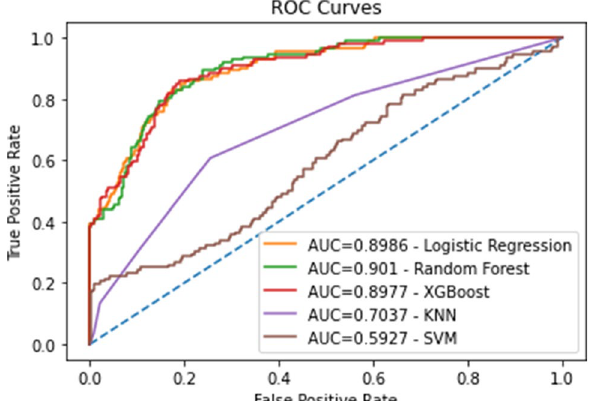
Figure 3. Evaluation of the machine learning models’ predictive abilities: receiver operating characteristic curves of all models plotted, along with area under the curve for each model listed in the